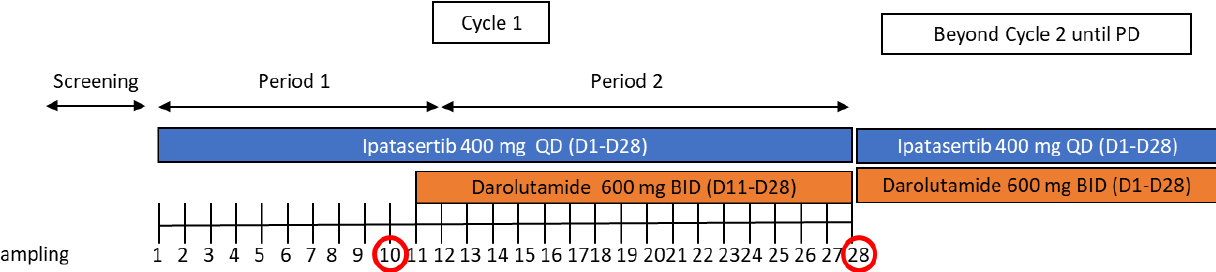
Figure 1. Schematic representation of the study design.